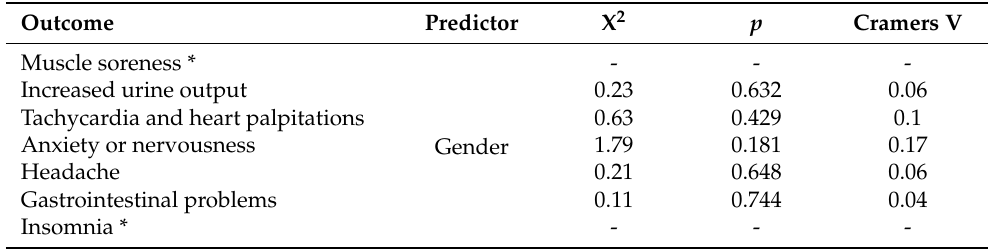
Table 2. Association between Gender predictor and particular NEGATIVE effects 60 min after CAF ingestion.